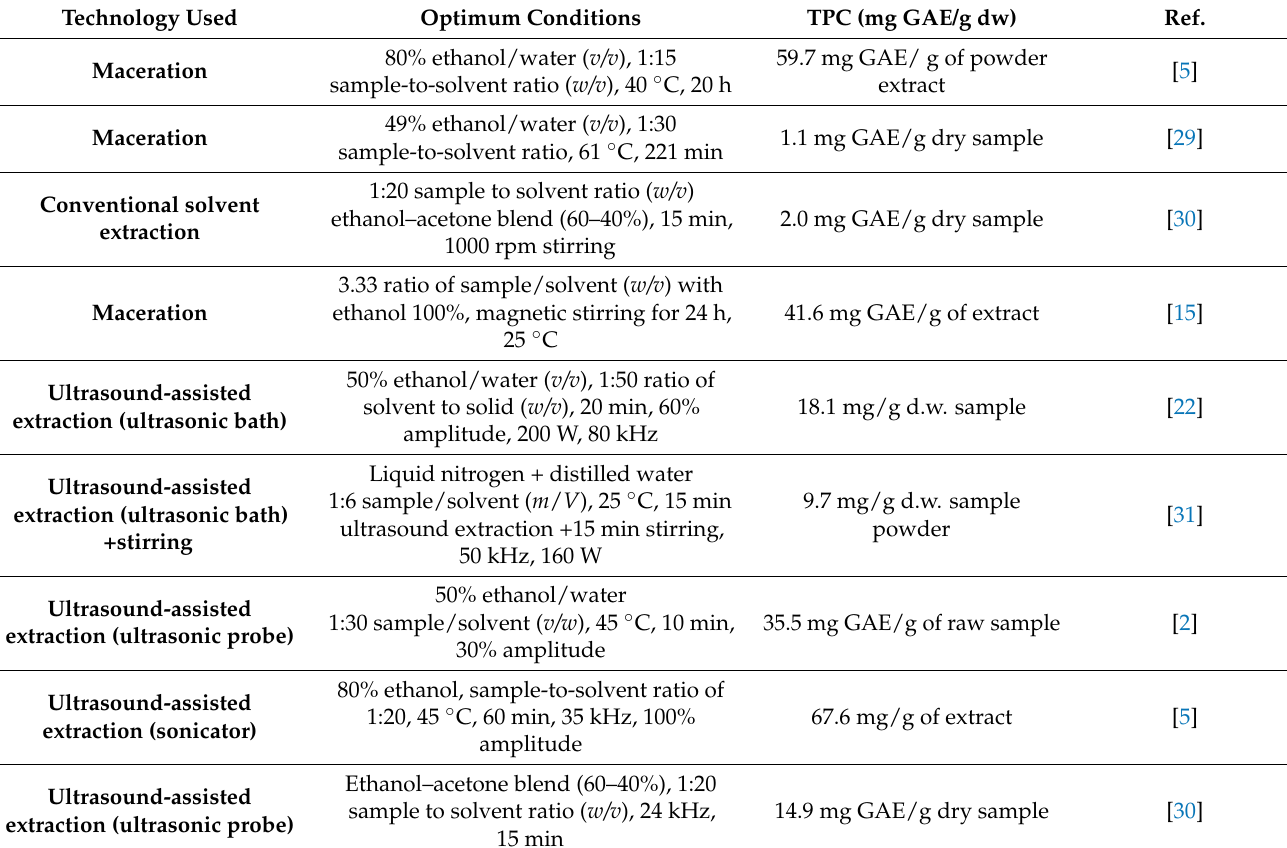
Table 4. Previous research about other technologies used for extracting phenolic compounds from the mango peel byproduct with the conditions used and the total phenolic compounds (TPC) obtained. Technology